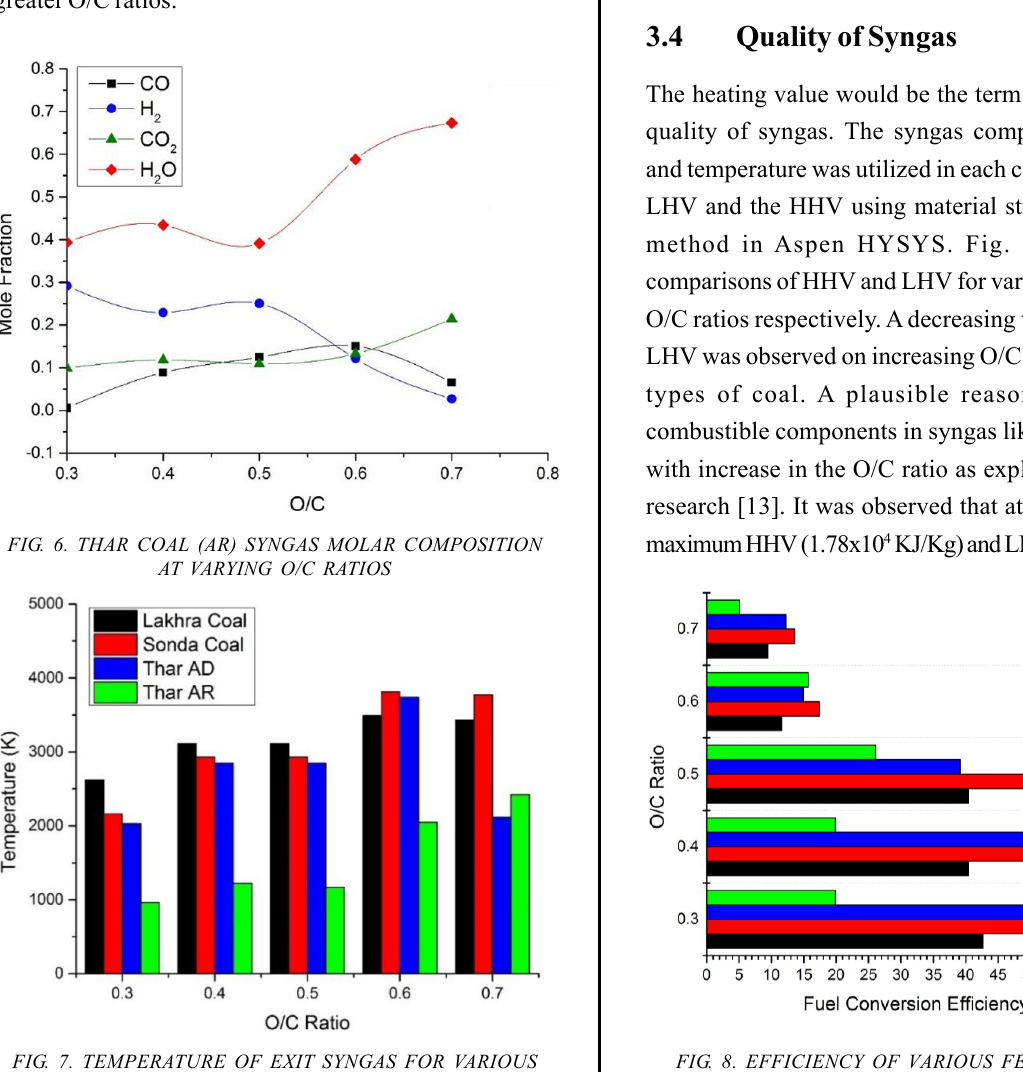
FIG. 8. EFFICIENCY OF VARIOUS FEEDSTOCK